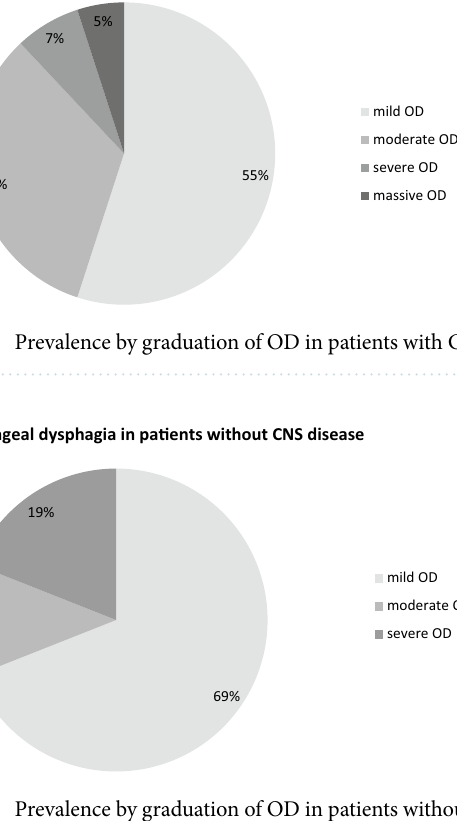
Most of the 58 patients with OD had normal kidney function (29.3%) or mild renal impairment (44.8%). Moderate renal impairment was noted in 14 (24.1%) patients and severe impairment in only 1 patient (1.7%). Compared to the entire study group (n = 195; 5 missing values), the classification was even worse, with normal kidney function in only 17.9% of patients, mild impairment in 55.9%, moderate impairment in 22.6%, severe impairment in 3.1%, and 1 patient (0.5%) with terminal renal failure. Among the 58 patients affected by OD, the most prevalent category of OD was the mild form (> 50%). This was true for both the patient group suffering from CNS diseases (n = 43; Fig. 2) and patients without CNS disease (n = 16; Fig. 3). Notably, 31% of the CNS disease-free OD patients were affected by a moderate to even severe (19%) form of OD. The detailed medication analysis revealed the absolute frequencies depicted in Fig. 4 for each drug group defined in our study. The prevalence (%) of the investigated drug groups comparing patients with OD and without OD is shown in Fig. 5. The ORs analysed as an estimate of the effect of the defined medication groups on OD indicated a clinical relevance for beta-blockers (OR = 1.3, 95% CI 0.69–2.54, p = 0.40). The risk of associated dysphagia with loop diuretics was 1.3-times that of patients who do not consume a loop diuretic (95% CI 0.70–2.38, p = 0.42). For antidementia drugs, the effect estimate was 1.1 (95% CI 0.32–3.71), but it decreased to 0.8 (95% CI 0.21–3.01, p = 0.73) after adjusting for CNS disease. The association of OD with opioids was 1.2-fold (95% CI 0.64–2.32, p = 0.54). The association of OD with alpha-blockers was 1.2 (95% CI 0.50–2.81, p = 0.69). The risk of OD when taking urologics is 5-times the risk without urologic use (95% CI 0.45–56.65, p = 0.20), but because of the extremely low number of patients involved (n = 3), we cannot provide relevant data. The risk of associated OD was increased 1.2 when taking anticholinergics (95% CI 0.22–6.92, p = 0.81). The association of OD with cloni- dine was 2.5 (95% CI 0.15–40.23, p = 0.52), but only two patients were involved. Antiemetics, antivertiginosa, or antihistamines had a risk of OD 1.3-times that of patients who did not take any of these drugs (95% CI 0.45–3.51, p = 0.67). The risk OD with metoclopramide or domperidone was increased twofold (95% CI 0.72–5.73, p = 0.18). The OD association with cytostatics was 2.5-fold (95% CI 0.15–40.23, p = 0.52) but cannot be considered here due to the low number and the variety within this medication entitiy. Ophthalmics also showed an increased association (OR = 1.8, 95% CI 0.65–5.02, p = 0.25). However, they include a very heterogeneous spectrum of pharmacological agents and the low number of absolute cases did not allow a differentiated statistical analysis of the various individual active ingredients in detail; yet, an anticholinergic component is frequent. There was not an increased association with calcium antagonists, ACE inhibitors, sartans, hydrochlorothi- azide, potassium-saving diuretics, PPIs, or uricosurics or uricostatics. Hyponatremia was found in a total of